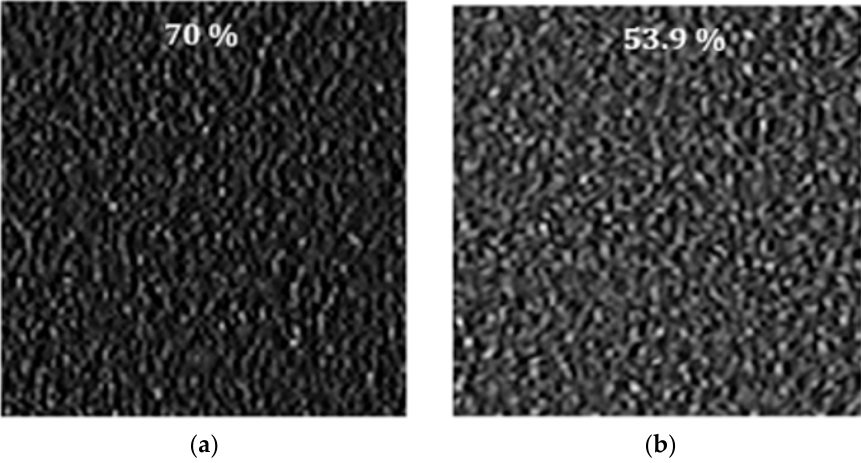
Figure 9. ( a ) Single-wavelength speckle image, ( b ) dual-wavelength speckle image.